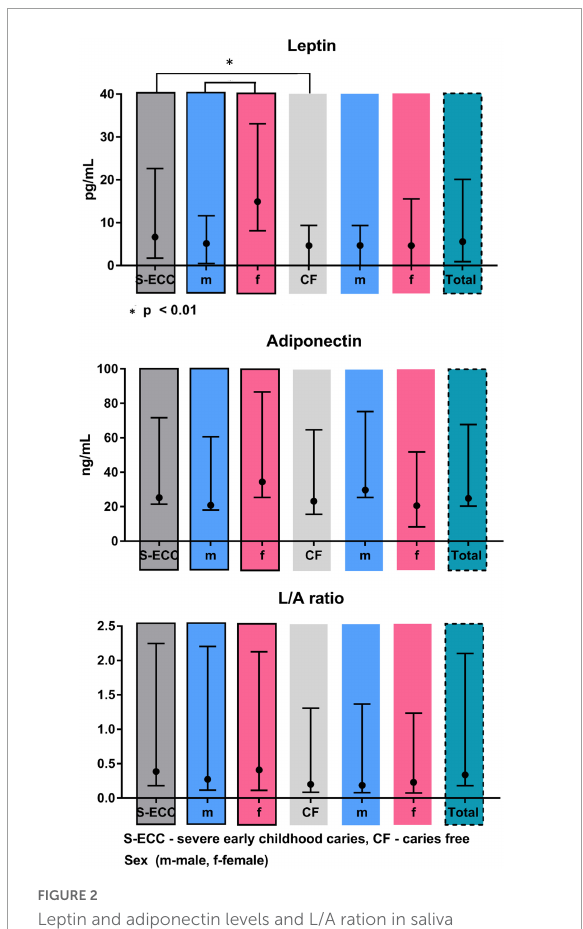
FIGURE2 Leptin and adiponectin levels and L/A ration in saliva supernatants of children with or without